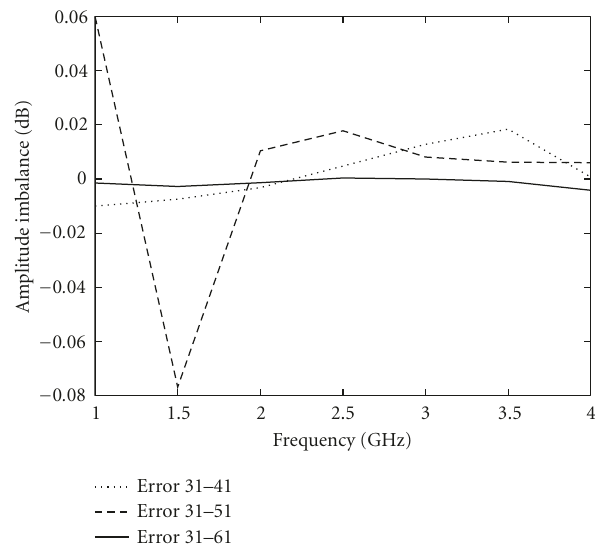
Figure 14: The predicted amplitude imbalance of an ideal 2 × 2 coupler.